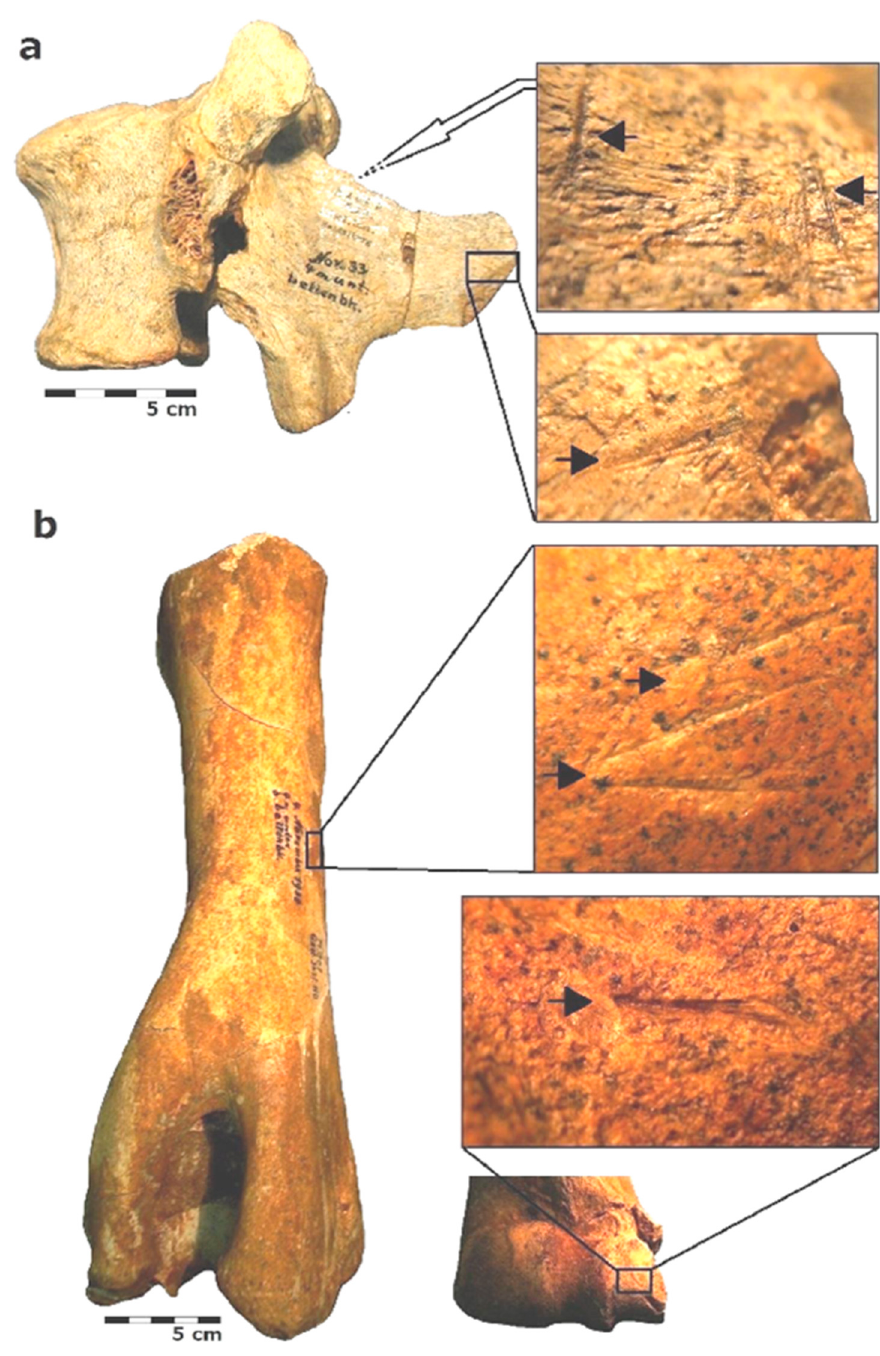
Figure 18. Mauer. ( a , b )Cutmarks on bones. (Photo and analysis by G. Landeck.).